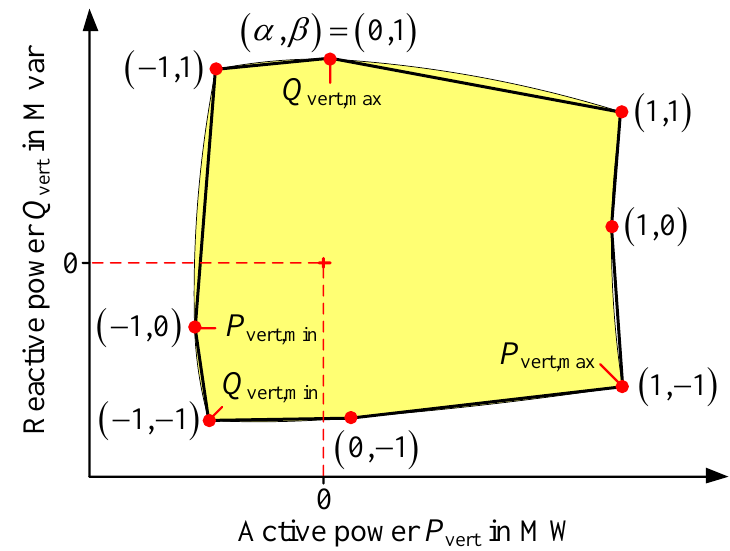
Figure 3. Example of initial sampling points of the